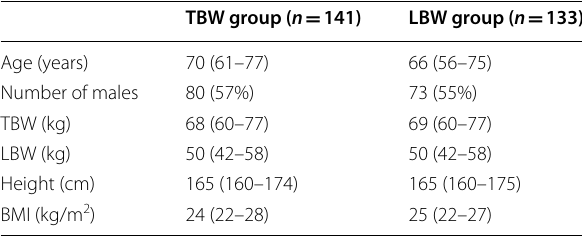
Table 1 Patients’ main characteristics